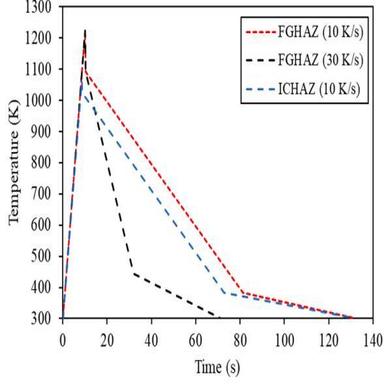
FGHAZ temperature-time profiles for precipitation kinetics simulations from Devaney .